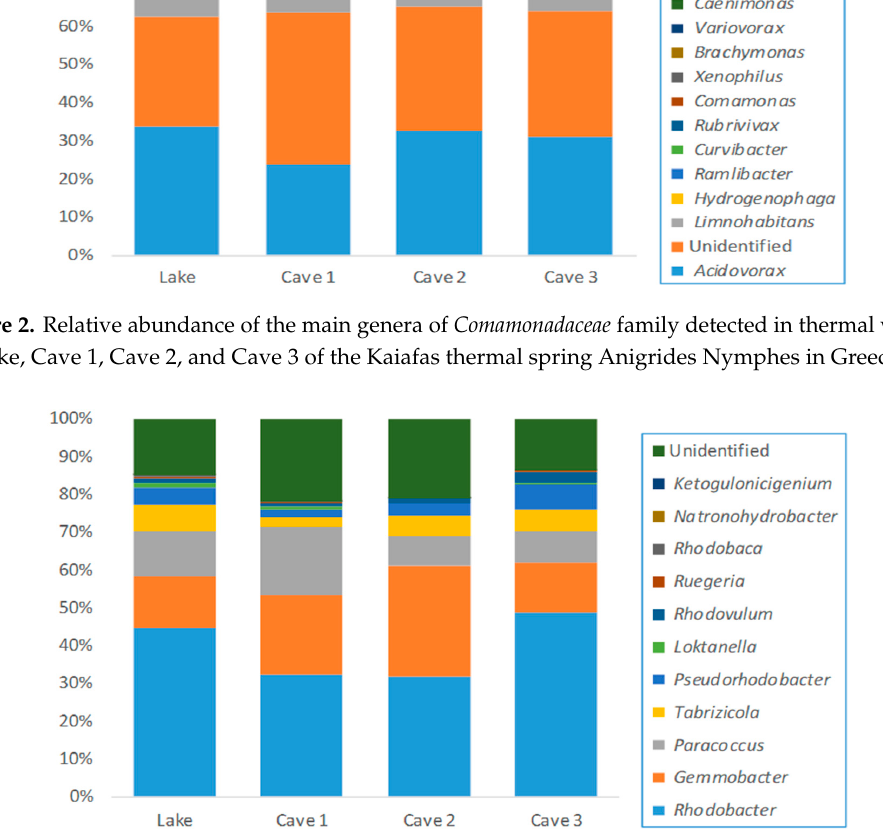
Figure 3. Relative abundance of the main genera of Rhodobacteraceae family detected in thermal waters of Lake, Cave 1, Cave 2, and Cave 3 of the Kaiafas thermal spring Anigrides Nymphes in Greece.